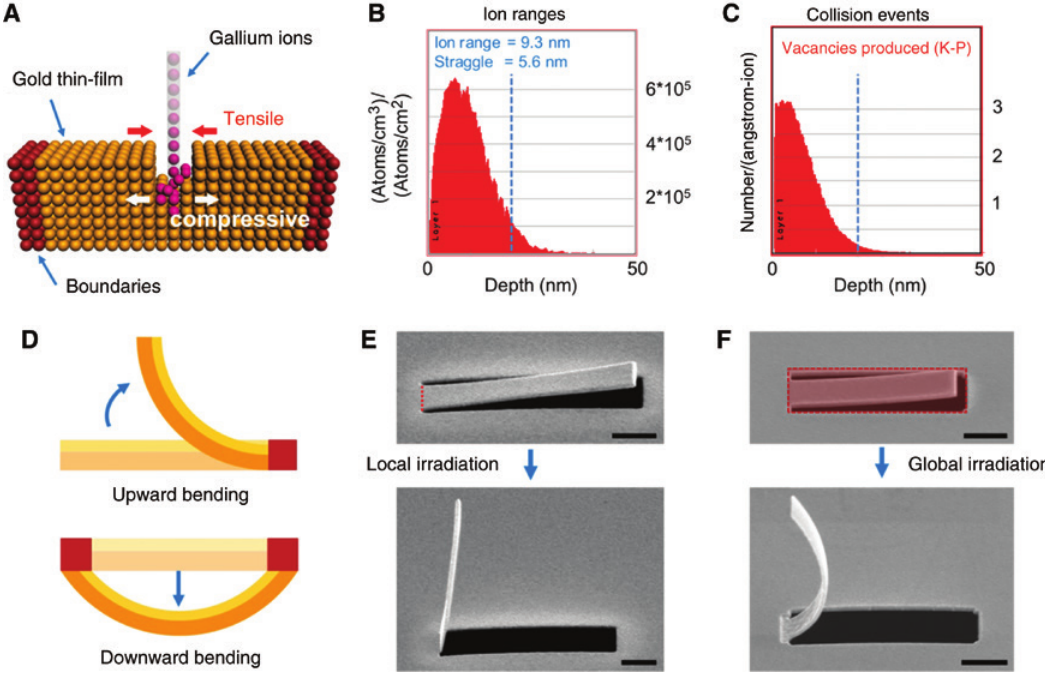
Figure 1: Mechanism of FIB-based